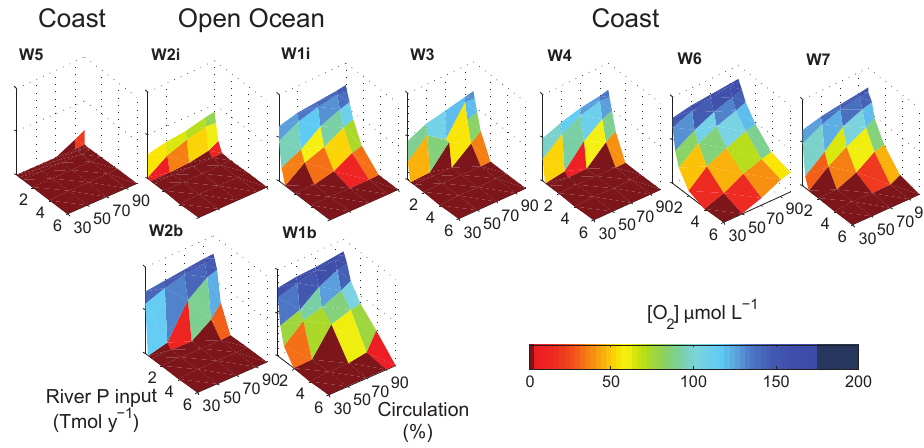
Fig. 6. Sensitivity of oxygen concentrations in the bottom water of each box to changes in river input of phosphorus and ocean circulation (E5). The ocean circulation is reduced from 100 to 30%. For further details, see the text.